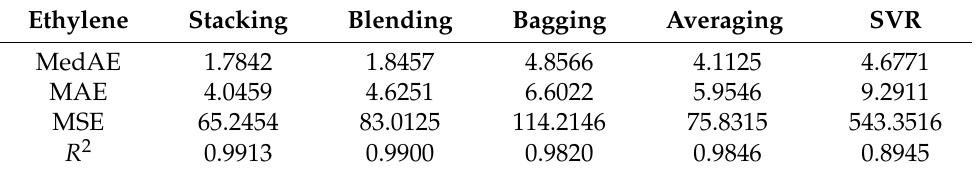
Table 6. Ethylene prediction